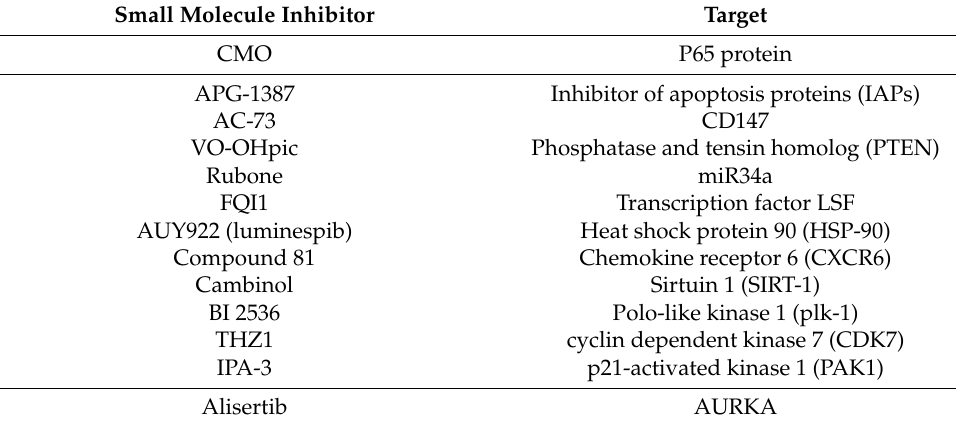
Table 2. Small molecule inhibitors and their different